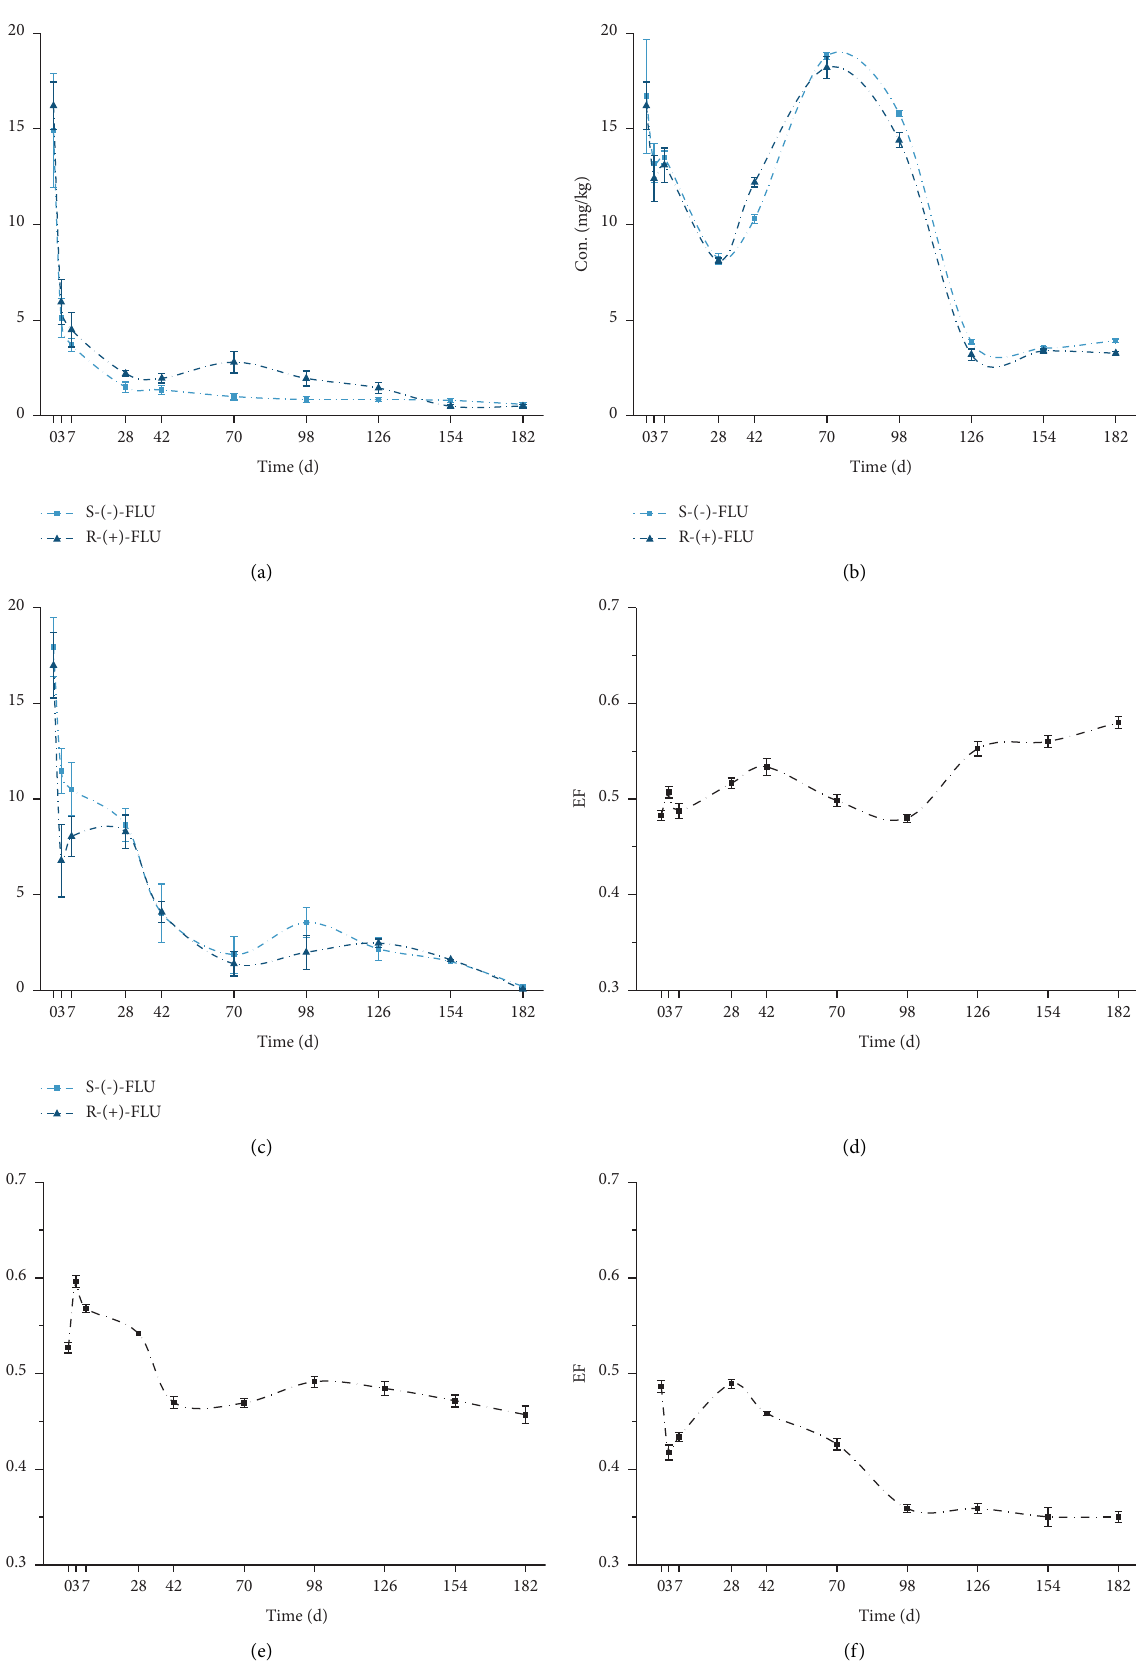
Figure 4: Degradation curves in 1# (a), 2# (b), and 3# (c) and EF variation in 1# (d), 2# (e), and 3# (f) of FLU in the three diferent sediments under natural conditions. Te points and error bars represent the mean and standard deviation of replicates, respectively ( n �